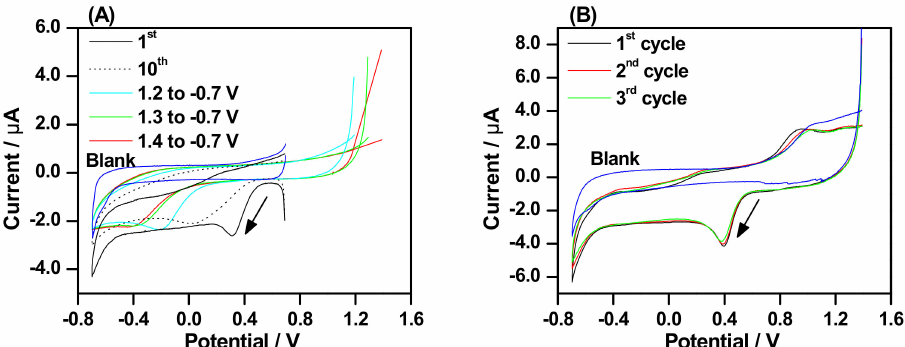
Figure 5. CVs of 0.15 mmol / L 4-CBD: ( A ) 1st (black line) and 10th (dot black line) cycle, scan range 0.70 to − 0.70 V; 1.20 to − 0.70 V (cyan line); 1.30 to –0.70 V (green line); 1.40 to − 0.70 V (red line); ( B ) Grafting of GCE from 1.40 to − 0.70 V: 1 st (black), 2nd (red), and 3rd cycle (green). Scan rate 0.10 V s − 1 . Blue lines in ( A ) and ( B ) represent blank and arrows show the direction of